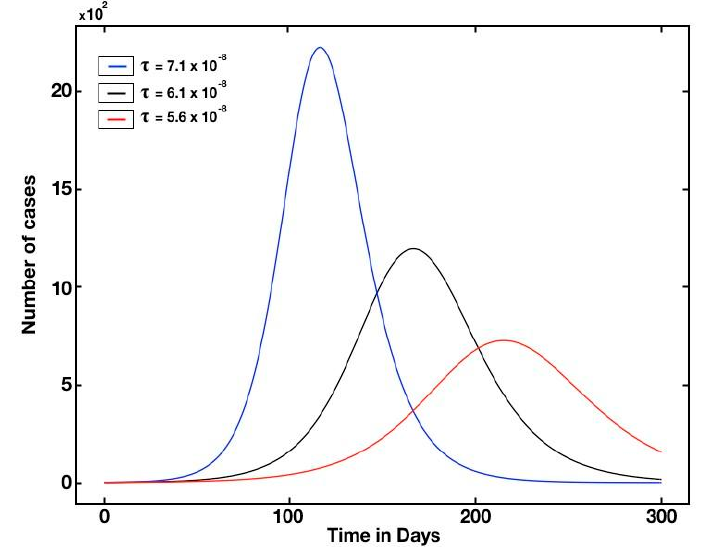
Figure 5. Simulated curves for several transmission rate.